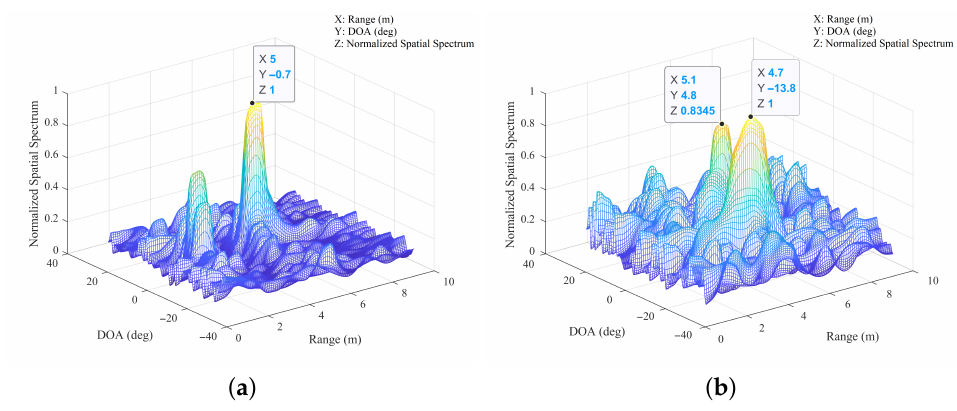
Figure 17. High-resolution imaging results: ( a ) Single target. ( b ) Two targets. As the validation of experimental data does not require a large number of Monte Carlo experiments, a fine grid [ 0.1 ◦ , 0.1 m ] was adopted. As shown in Figure 18, the estimation with 2D-MUSIC needed several minutes; in contrast, the proposed algorithm only took 0.45 s, which shows the real-time advantage of the algorithm. Figure 19a,b shows the imaging results of the one and two-target experimental data obtained using the original 2D-MUSIC. It can be seen that with a complete noise subspace and a fine grid, 2D-MUSIC can achieve very sharp spatial spectrum peaks. However, these results are obtained at the cost of extremely long running times, and the real-time performance is extremely